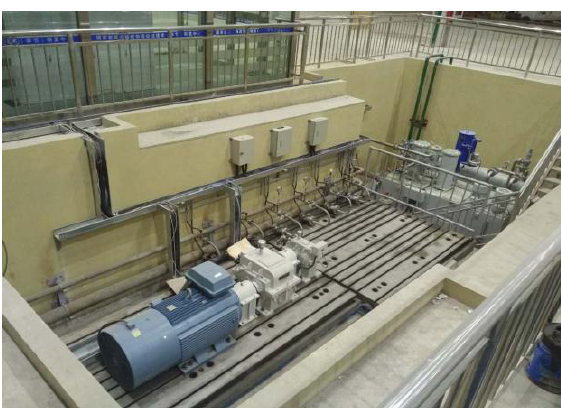
Figure 17. Multi-axis coupling and high-speed rotor dynamic test platform [75].